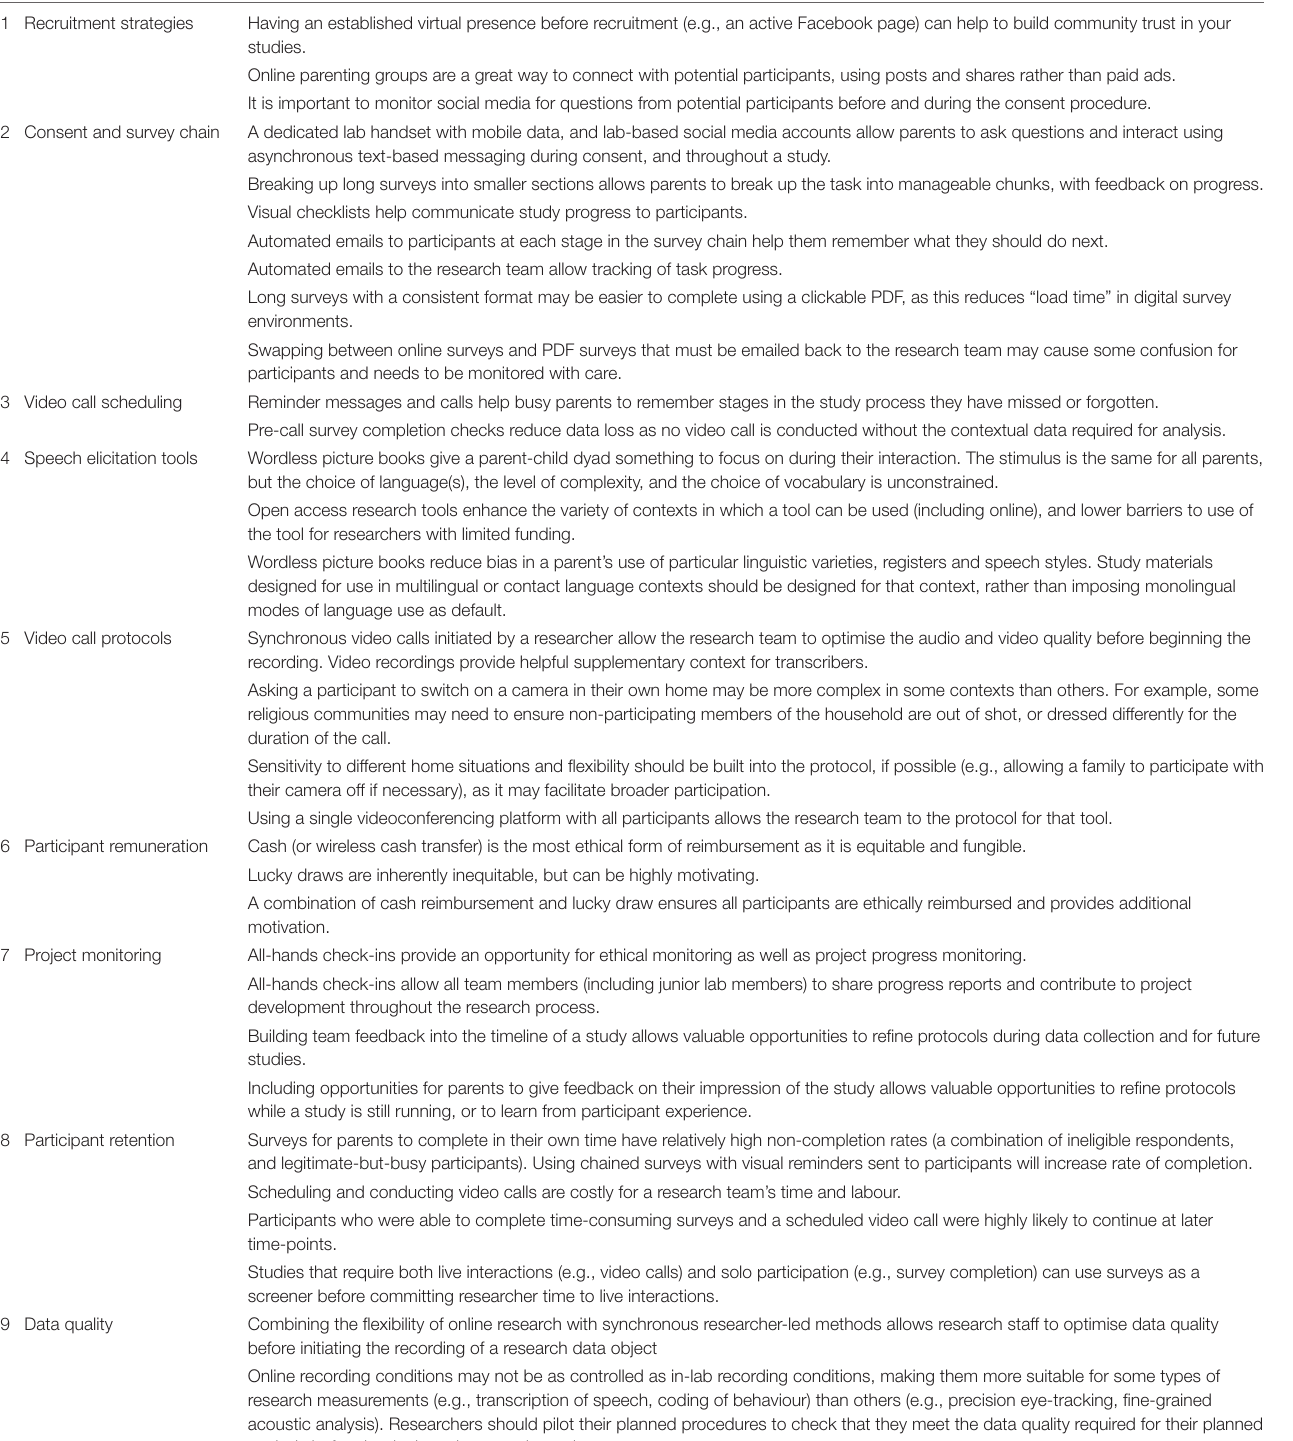
TABLE 1 | Summary of lessons